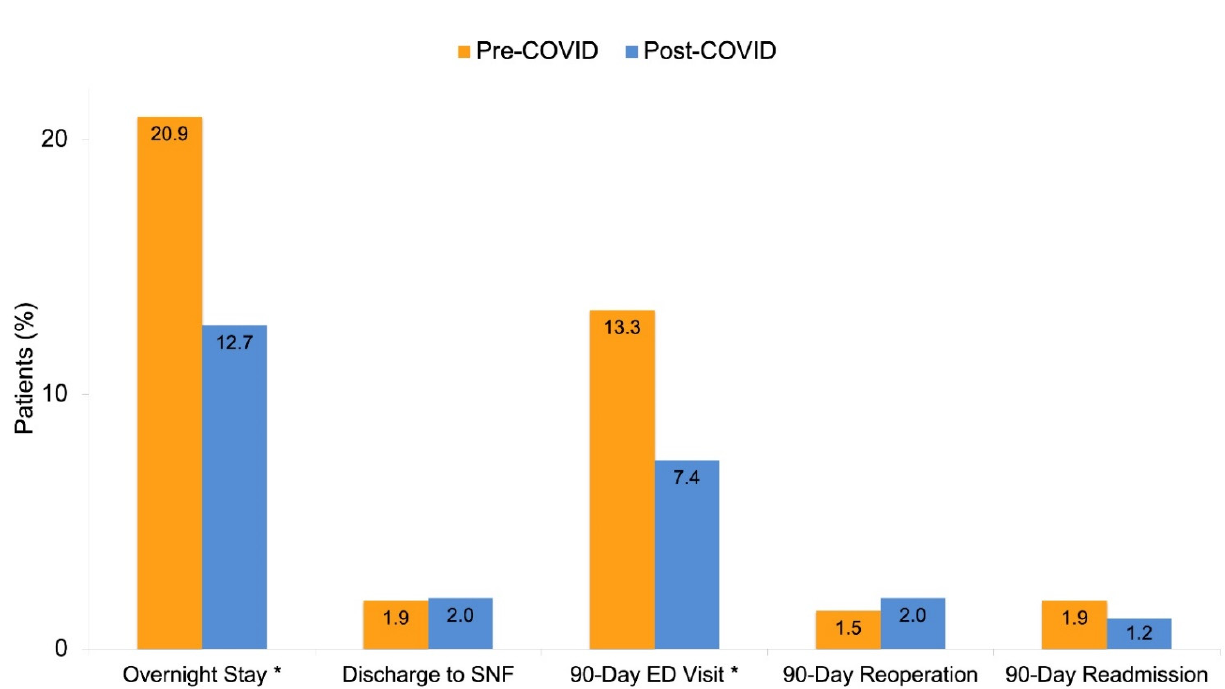
Figure 1. Outcomes after total shoulder arthroplasty in the pre- and post-COVID groups. Asterisks denote statistical sig- nificance ( p < 0.05).